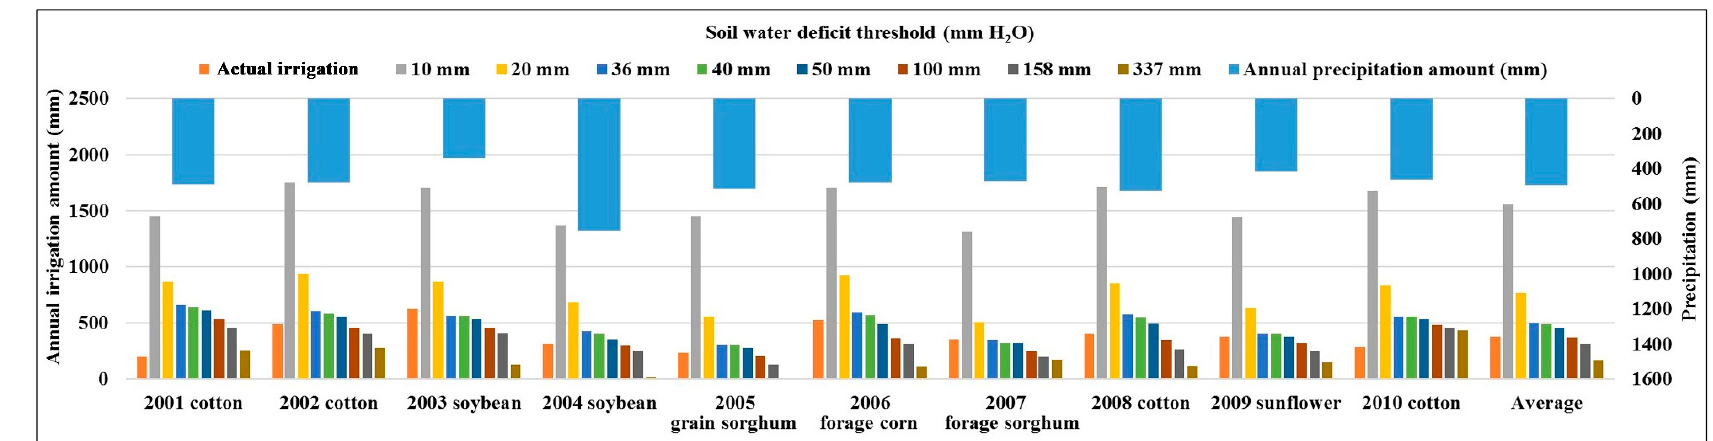
Figure 7. Irrigation amounts (mm) of actual management and simulated soil water deficit triggers using the auto-irrigation functions in SWAT. Annual total precipitation values are also shown.